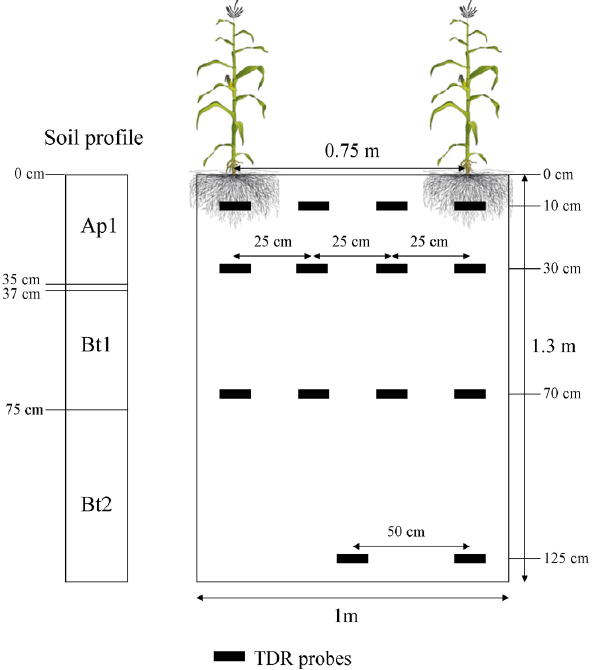
Fig. 1. Depths of the soil horizons (Ap1, plough pan layer, Bt1 and Bt2) and position of TDR probes.